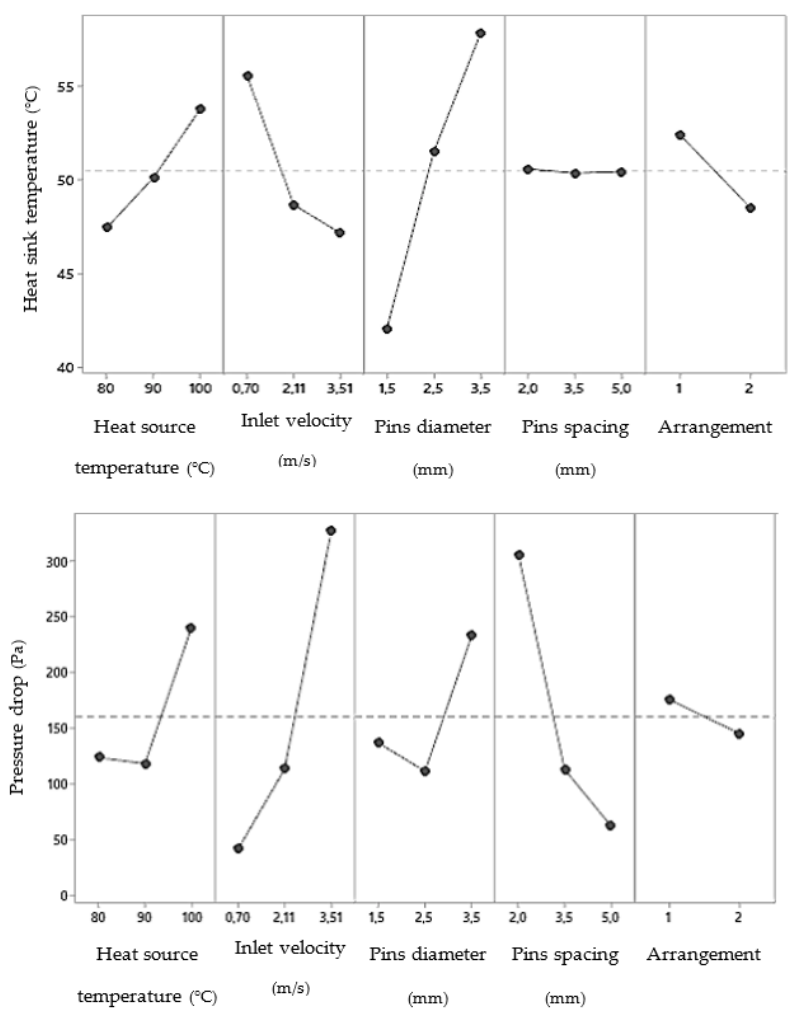
Figure 13. Main effects for heat sink temperature ( top ) and pressure drop ( bottom ) for pins heat sinks. Pins Shape